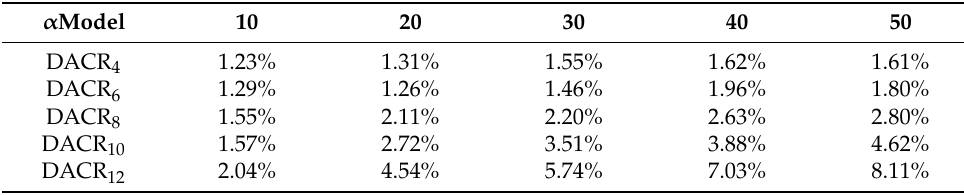
Table 8. The average MAE improvement compared to no CS item rating added.